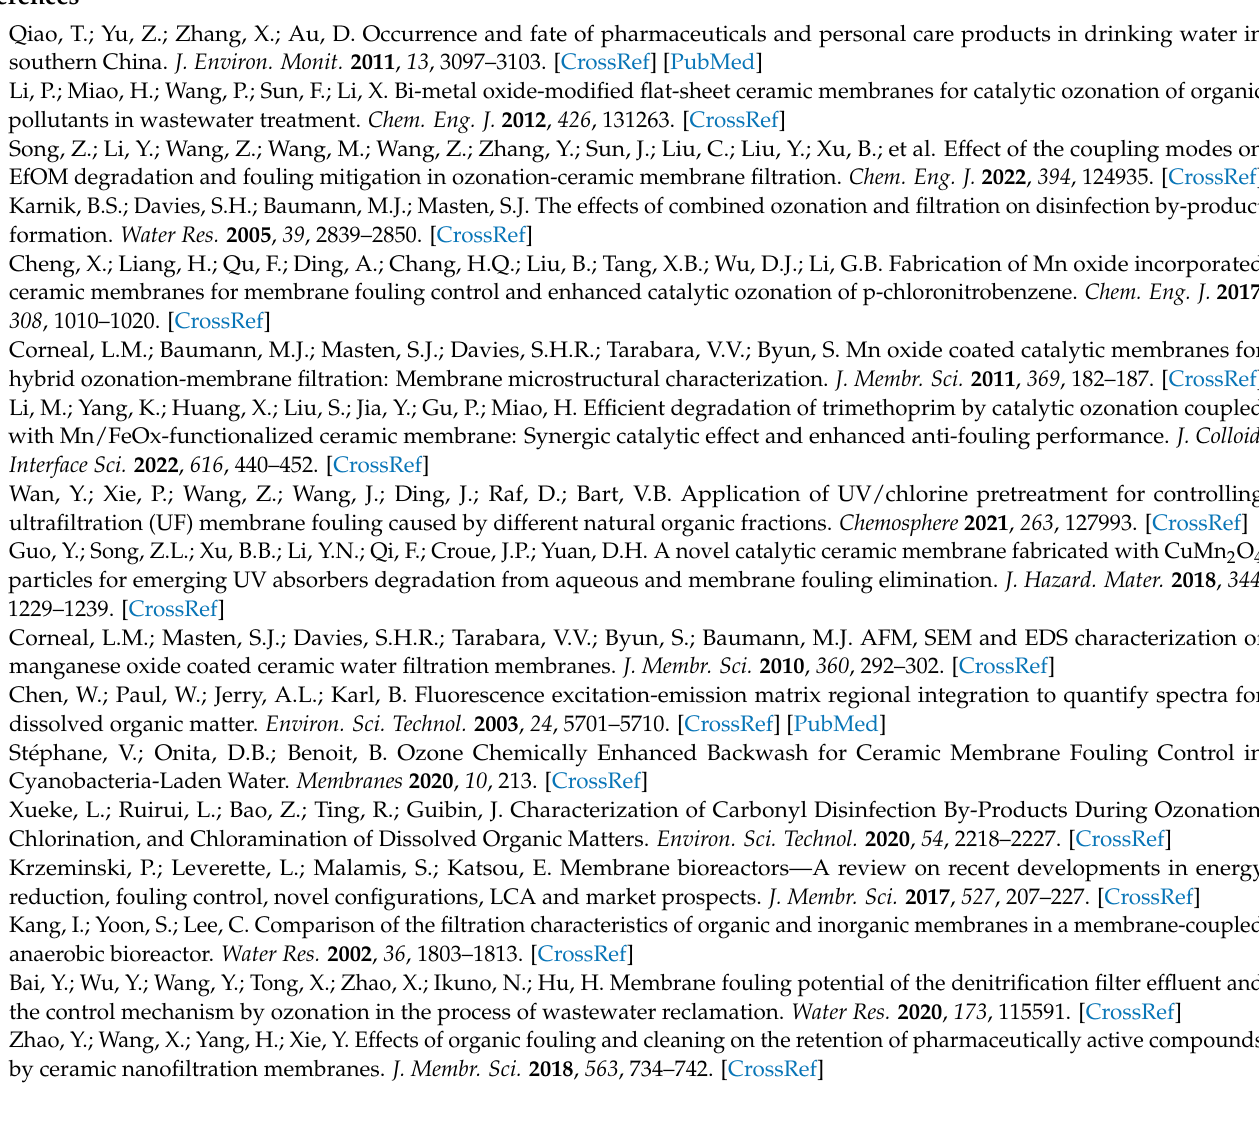
Figure S7: Effect of radical scavengers on the degradation of TMP, Figure S8: EPR spectra in